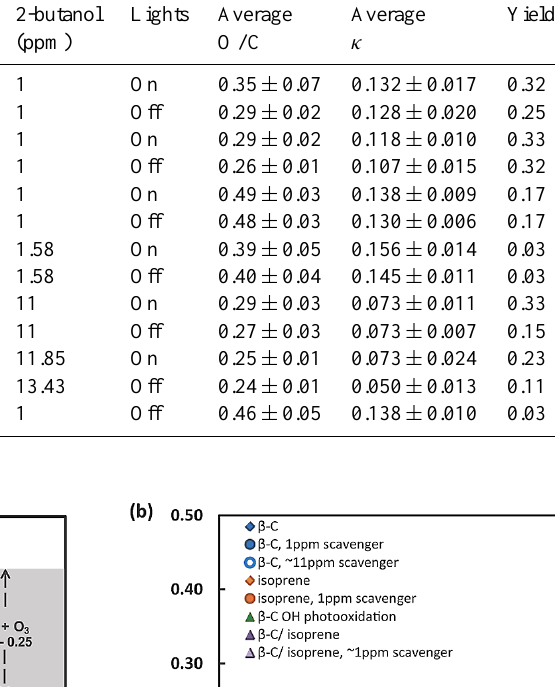
Table 2. Experimental conditions with OH scavenger.